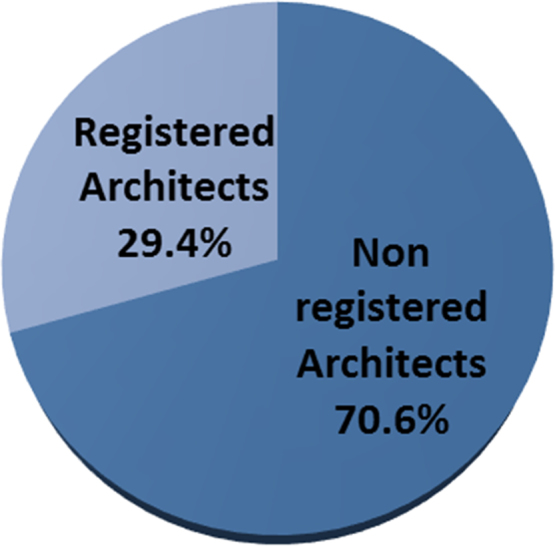
Registration status.